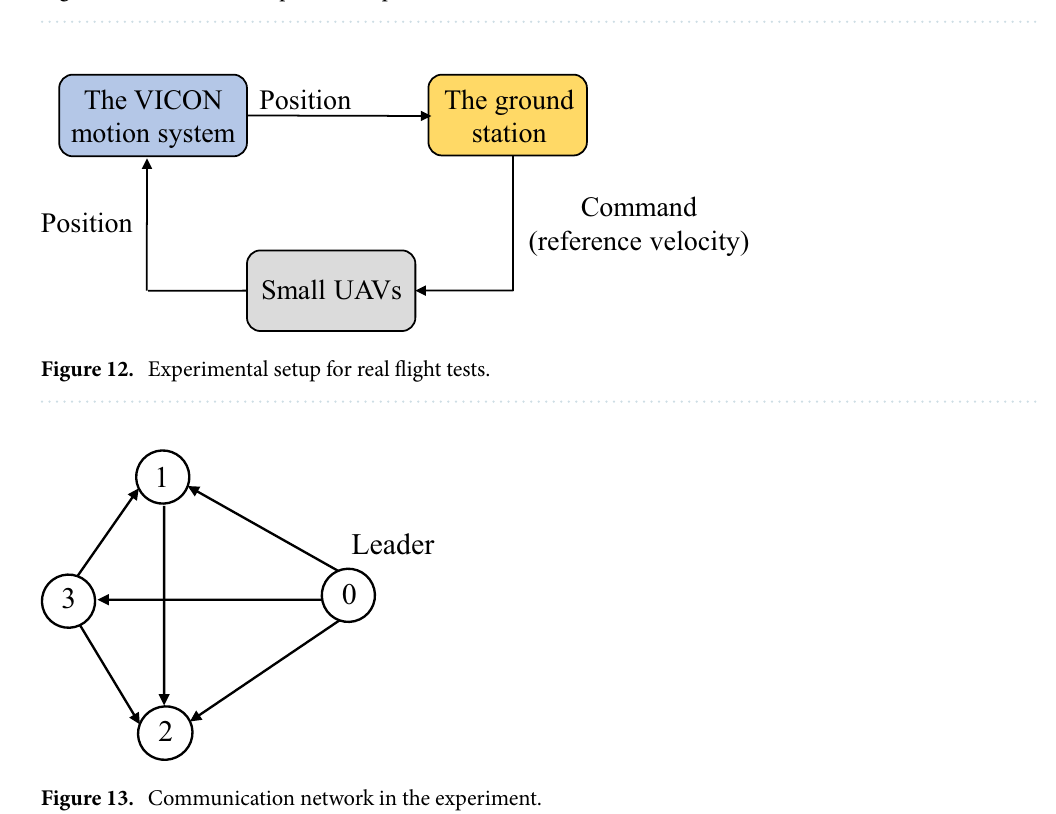
Figure 11. Small UAVs experimental platform.